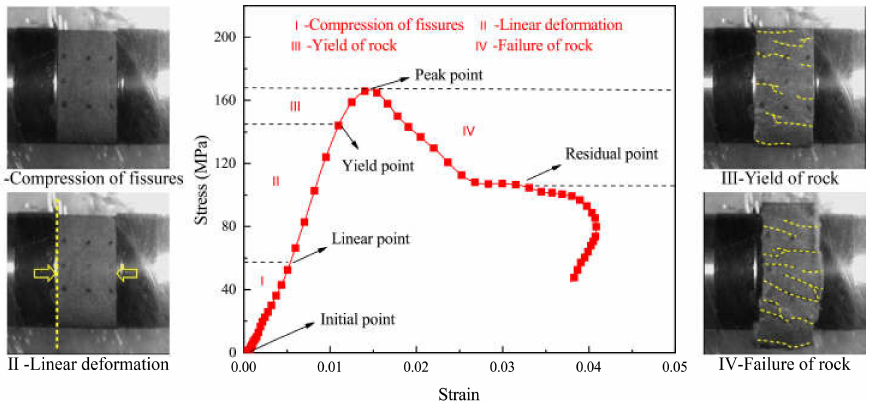
Figure 9. Schematic diagram of stress–strain curve and schematic diagrams of different macroscopic failure stages of the